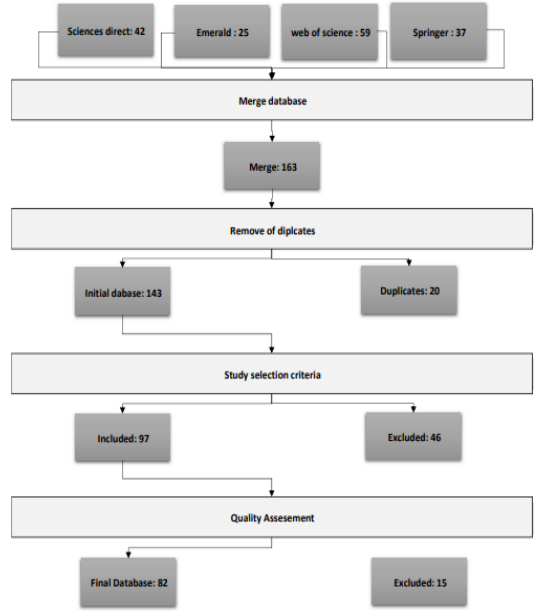
Fig 1. Steps of the systematic review